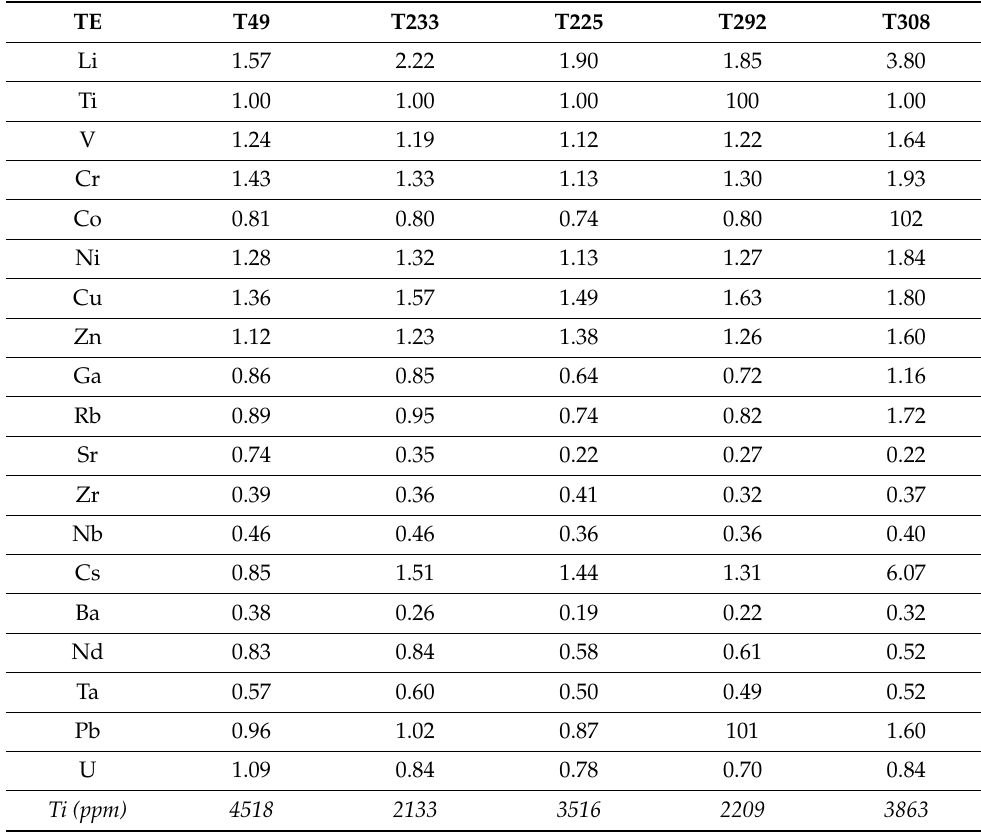
Table A1. TE enrichment factor of dust filters relative to the UCC [69]. Ti is the crustal element of reference and its concentration (ppm) in each sample is displayed in